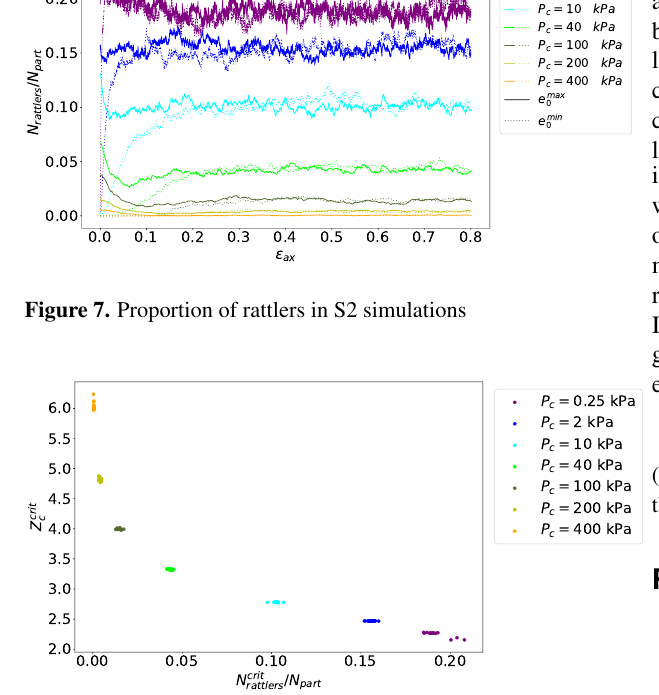
Figure 8. Critical mean coordination number against critical pro- portion of rattlers in S2